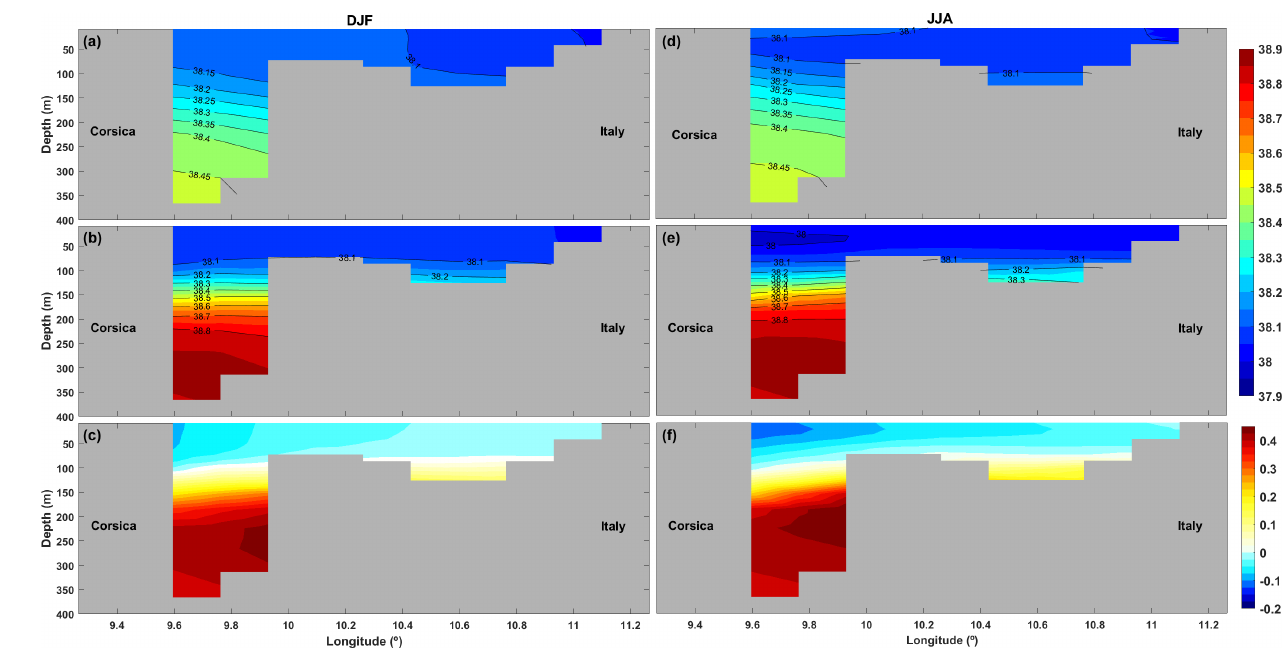
Figure 9. This is equivalent to Fig. 8 but constructed for the Corsica Channel.